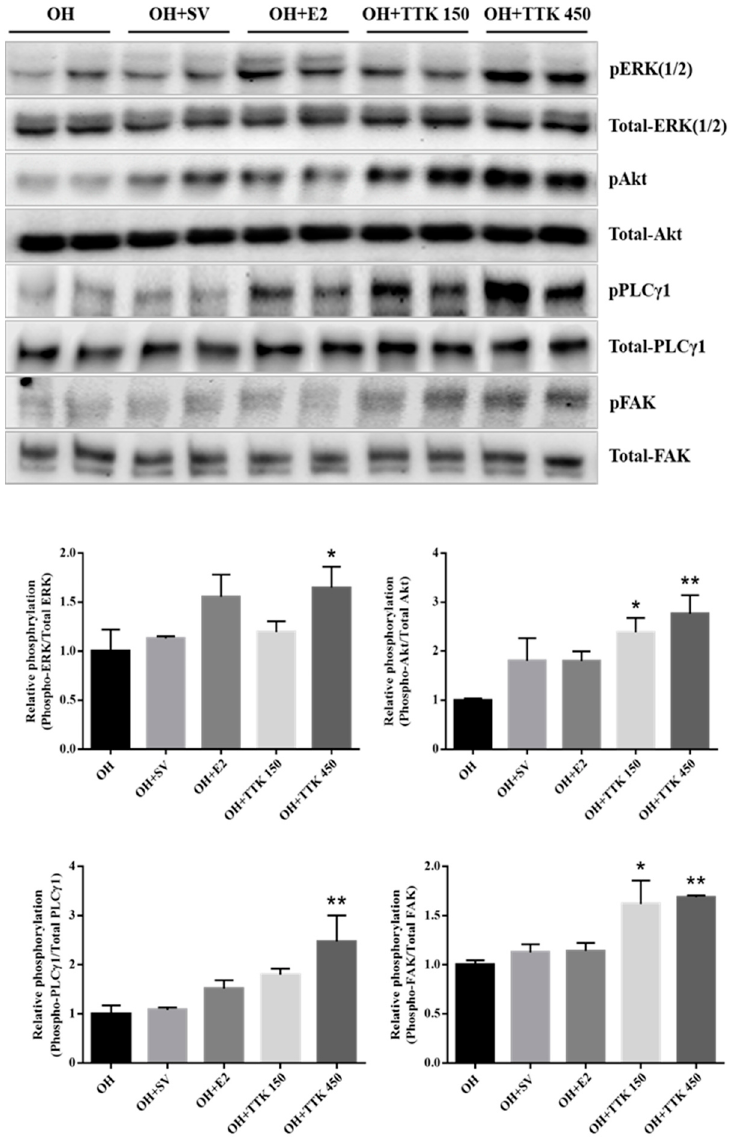
Figure 6. Angiogenic effects of TTK in ischemic limb. Western blotting assay to determine the expression of phosphor-ERK(1 / 2), ERK(1 / 2), phosphor-Akt, Akt, phosphor-FAK, FAK, phosphor-PLC γ 1 and PLC γ 1 contained in the ischemic hind limb on day 28 after surgery. * p < 0.05, ** p < 0.01 vs. OH.